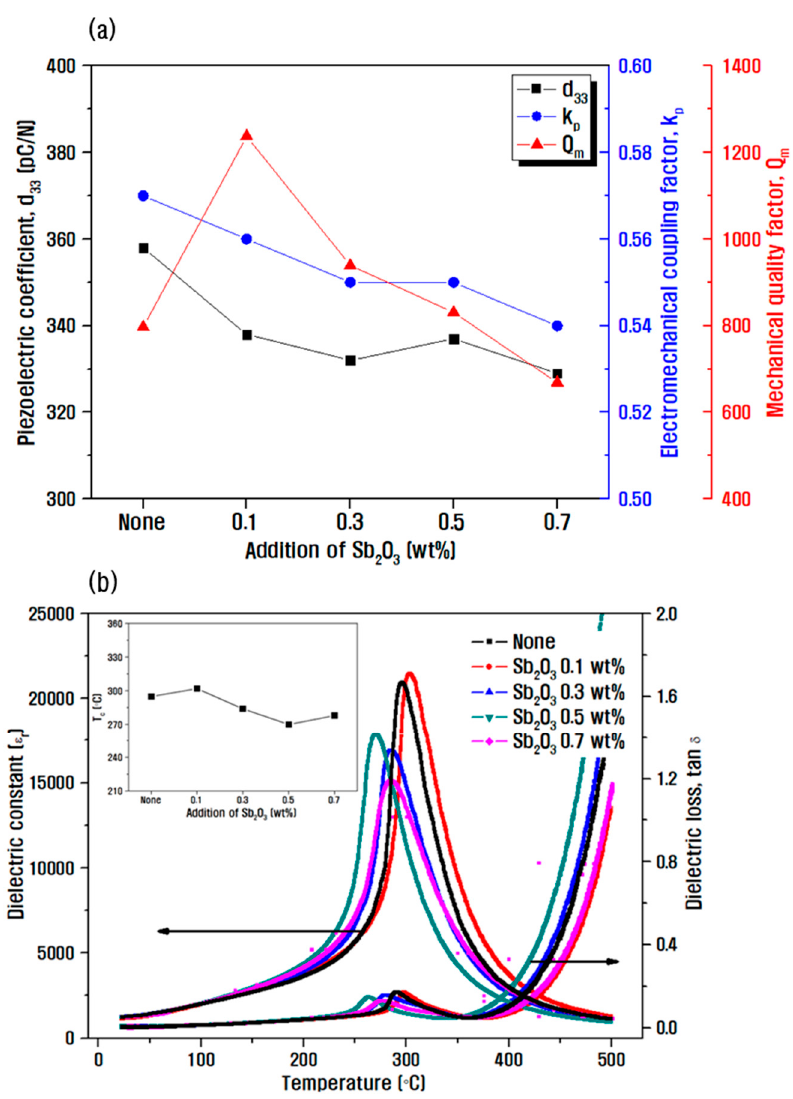
Figure 5. ( a ) change in electrical properties represented by d 33 , k p , and Q m according to Sb 2 O 3 doping amount, and ( b ) dielectric properties according to temperature change at 1 kHz measurement (inset graph: the change in Curie temperature according to Sb 2 O 3 amount) in PZN-PMN-PZT ceramic. The composition of 0.14PZN-0.06PMN-0.80PbZr 0.5 Ti 0.5 0.1 wt.% Sb 2 O 3 with piezoelec- tric properties d 33 = 338 pC/N, k p = 0.56, and Q m = 1237 in Figure 5 was considered suitable